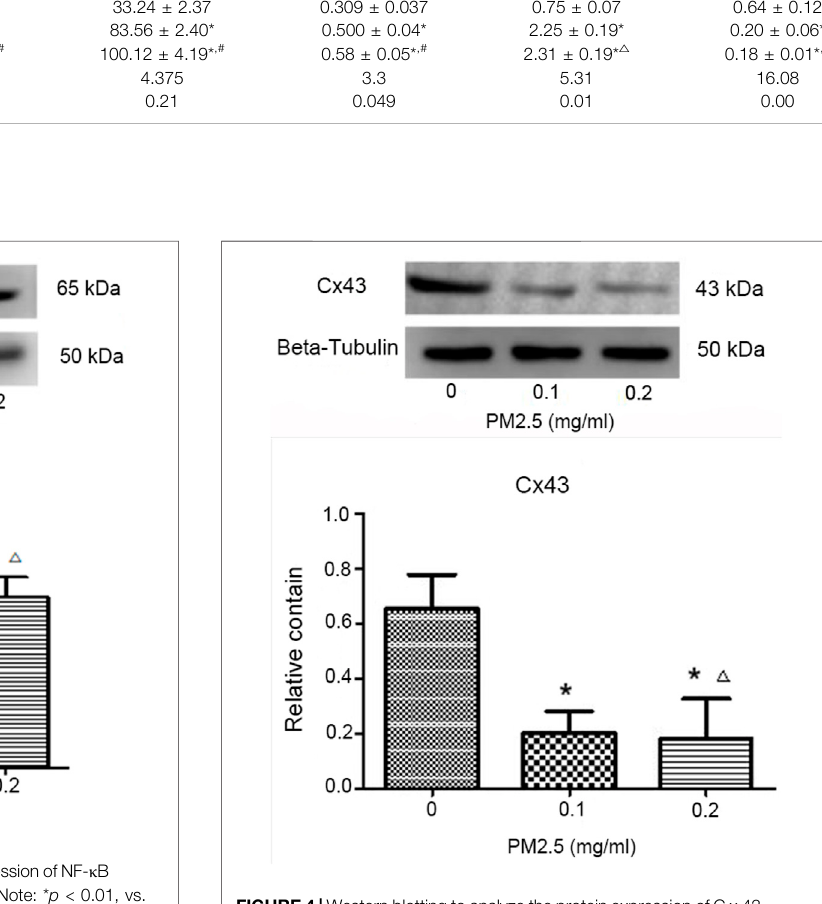
FIGURE 4 | Western blotting to analyze the protein expression of C x 43 and the relative protein expression of C x